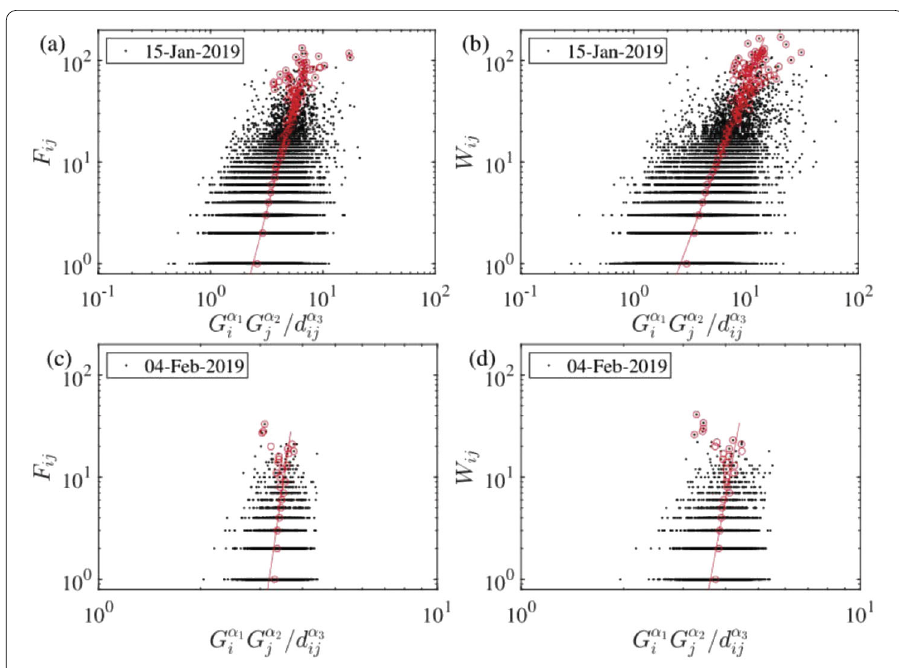
Figure 14 Testing the modified gravity law with GDP for the daily directed and undirected freight highway transportation networks. ( a ) The directed network on 15 January 2019. ( b ) The directed network on 15 January 2019. ( c ) The directed network on 4 February 2019. ( d ) The undirected network on 4 February 2019